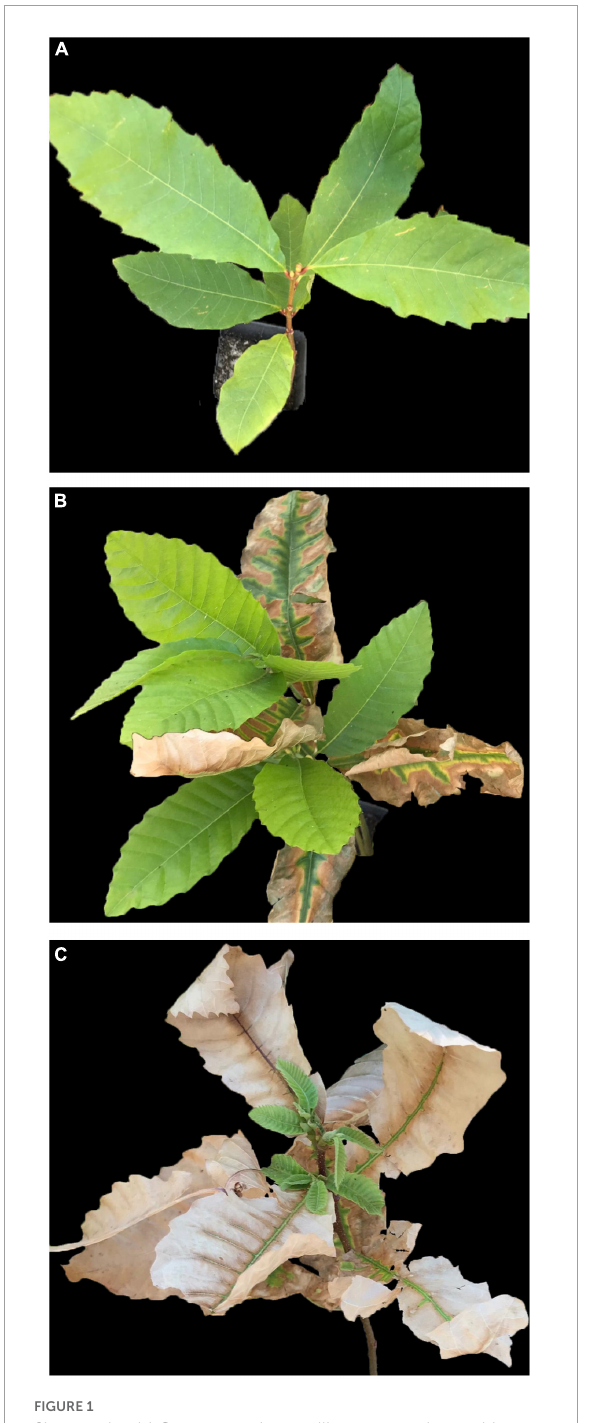
FIGURE1 Six-month-old Castanea sativa seedlings exposed to ambient conditions (A) , heat stress conditions for 7 days (B) , and ambient conditions for 10 days after heat stress ceased (C) . Heat scorching is observed on the foliage of stressed plants, starting with browning of the leaf margins, and/or yellowing or darkening of the areas between the main leaf veins. Ten days after heat treatment ceased, the foliage of the scorch-affected plant finally wilted, but the buds were viable, and the plant started to